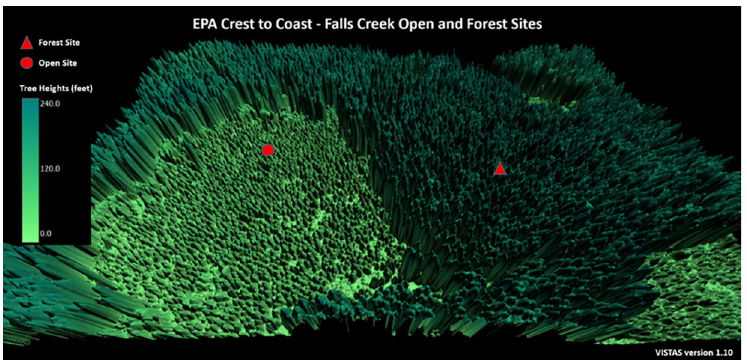
Fig 5. Falls Creek open-site and forest-site. Sites are part of the Oregon Crest-to-Coast Environmental Monitoring transect (O’CCMoN) dataset. Figure is the gridded 3D representation of the site generated from LiDAR data. https://doi.org/10.1371/journal.pone.0206439.g005 and root mean square error (RMSE) were used to evaluate Penumbra’s simulated goodness- of-fit to the observed field data. Mentioned before, by default Penumbra’s solar energy units are W/m 2 , though the instrumentation collecting the O’CCMoN solar energy data are in PAR ( μ moles/m 2 /s). Without pyranometer data for the sites a detailed full light spectrum data con- version could not be carried out. The generalized unit conversion was utilized due to the lack of full light spectrum data [21]. Moose Mountain results. The uncalibrated Moose Mountain simulation yielded moder- ate four-day open-site agreement with a percent-error of 0.511, mean-error of 286.1 ( μ moles/ m 2 /s) and RMSE of 506.0 ( μ moles/m 2 /s) (Table 3). The uncalibrated predictive skill for the for- est-site was worse due to no calibration being applied to the global energy and forest transmit- tance. The forest-site yielded a four-day agreement with a mean-error of -10.0 ( μ moles/m 2 /s), RMSE of 77.8 ( μ moles/m 2 /s), percent-agreement of 1.55 (Table 3). Calibration of Penumbra greatly improved PAR predictions for the open-site and moder- ately improved the forest-site (Fig 6); calibration parameters listed in Table 3. The Moose Mountain open-site final calibration provided an excellent observed versus simulated PAR agreement with a RMSE of 224.5 ( μ moles/m 2 /s), mean-error of -17.27 ( μ moles/m 2 /s), and per- cent-error of 1.029. The Moose Mountain forest-site final calibration provided a fair percent- error of 1.84, yet a greatly reduced RMSE of 53.78 ( μ moles/m 2 /s). The forest-site mean-error had a minor shift to -15.57 ( μ moles/m 2 /s) (Table 3). The VISTAS Moose Mountain static frame spatially represents the calibrated run results (Fig 7). Moose Mountain video portrays the dynamic simulation (S1 Video). To replicate results, use the provided model and test data (S1 Data).